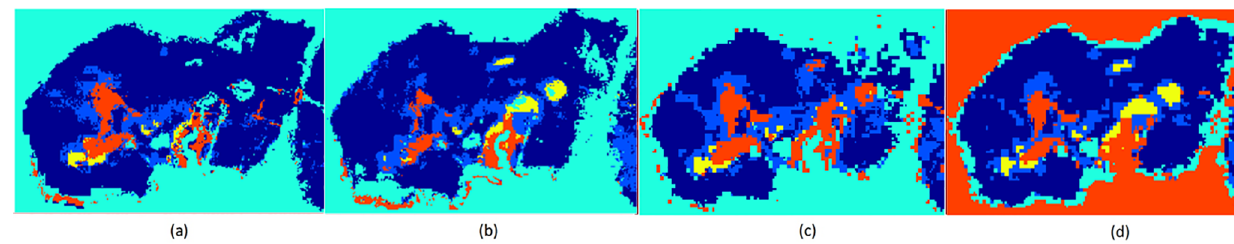
Figure 6. SVM Classified Image: (a) Sentinel-2 Case 1 (b) Sentinel-2 Case 2 (c) Landsat-8 Case 1 (d) Landsat-8 Case 2.